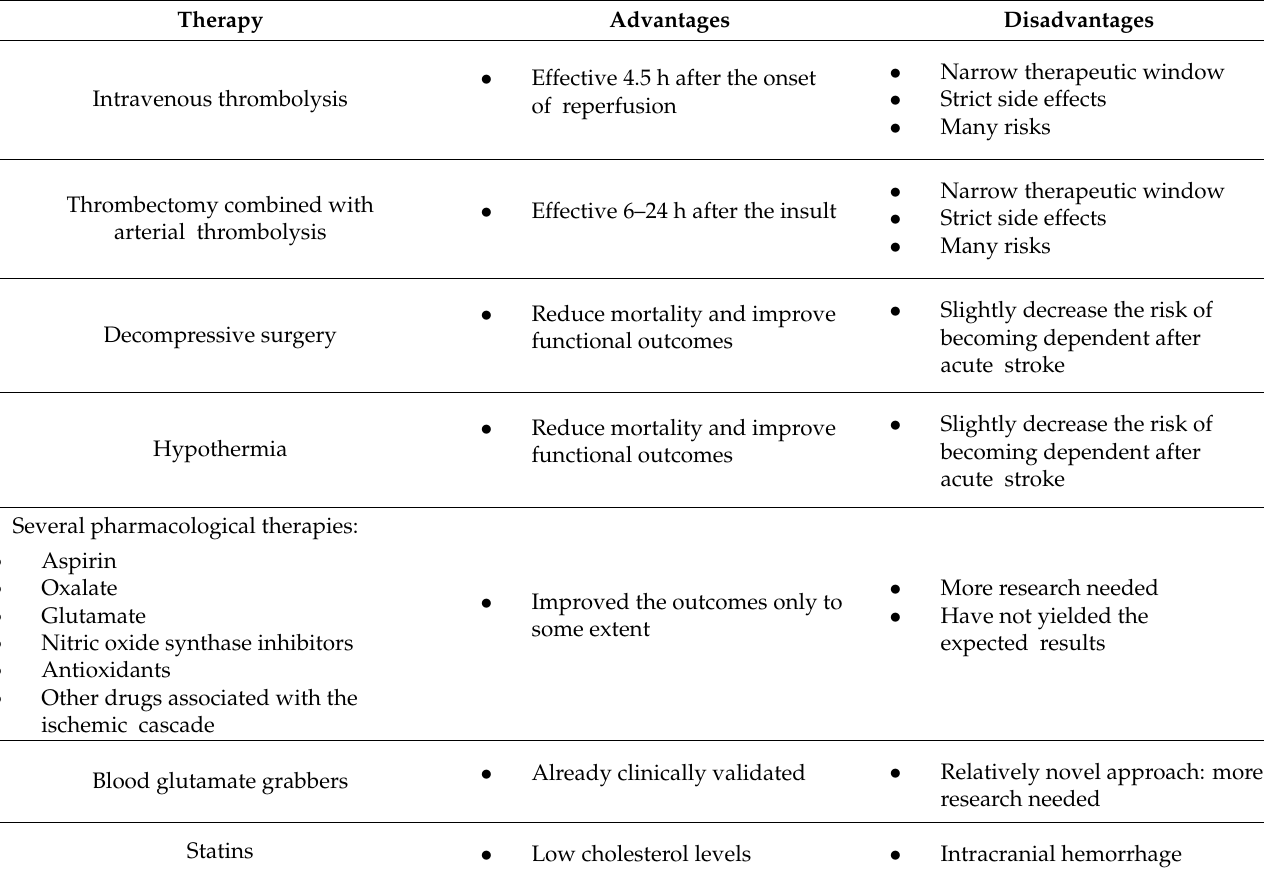
Table 1. Current treatments against